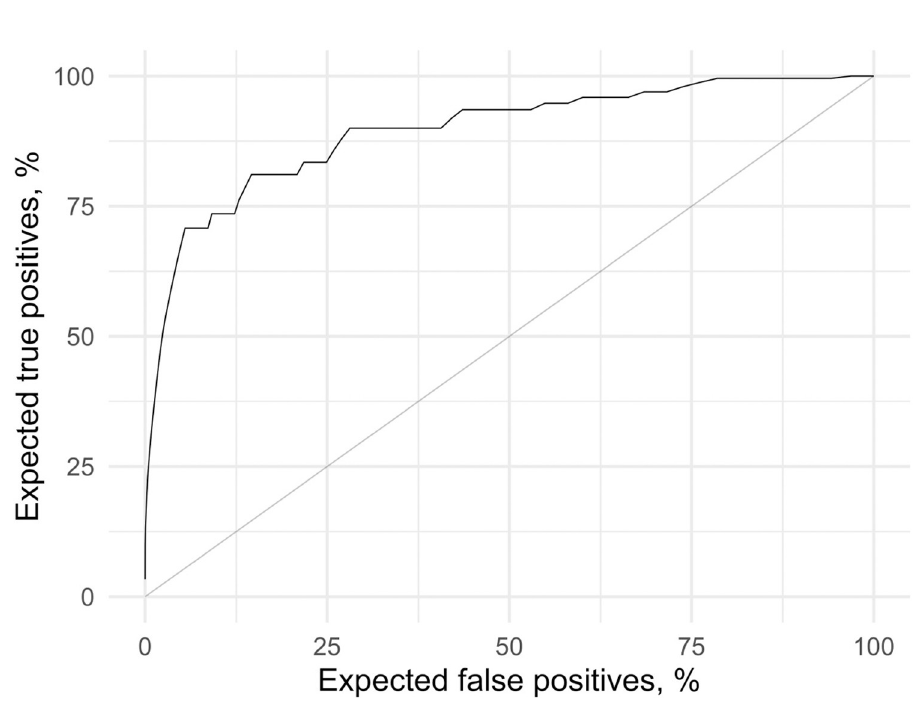
Fig 6. Leave-one-out ROC curve (AUC = 0.895).